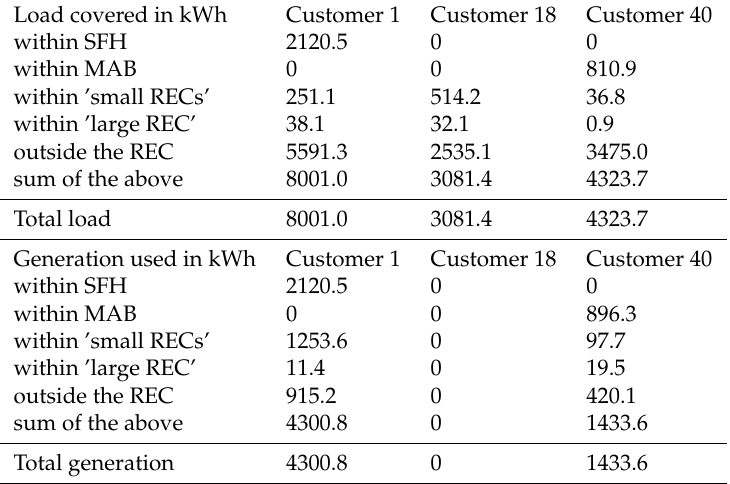
Table 3. Validation of the simulation model. Results provided for the case study of a purely residential REC. Customer 1: SFH with privately-owned PV; Customer 18: MAB without PV; Customer 40: MAB with externally-owned